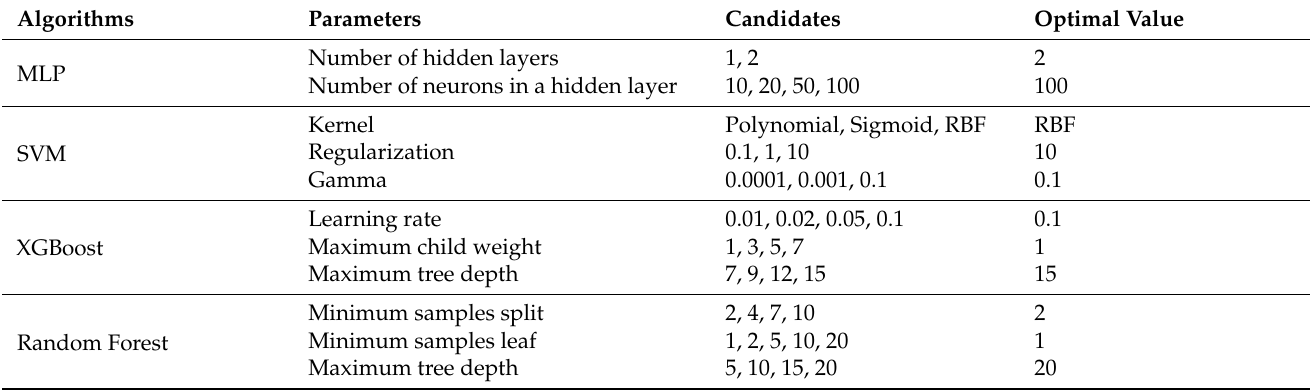
Table 1. Tuning parameters, candidates, and optimal values of each machine learning models.